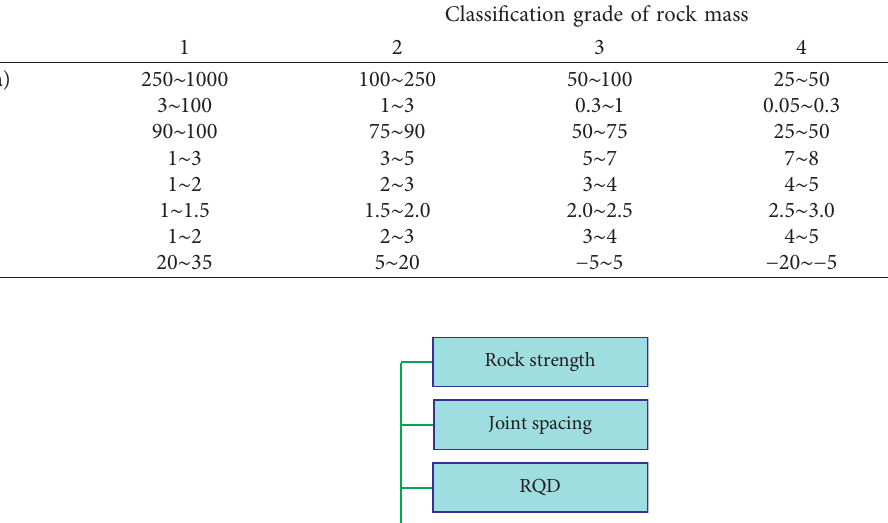
Table 4: Classification standard for the evaluation index of rock mass quality [8, 10, 18].